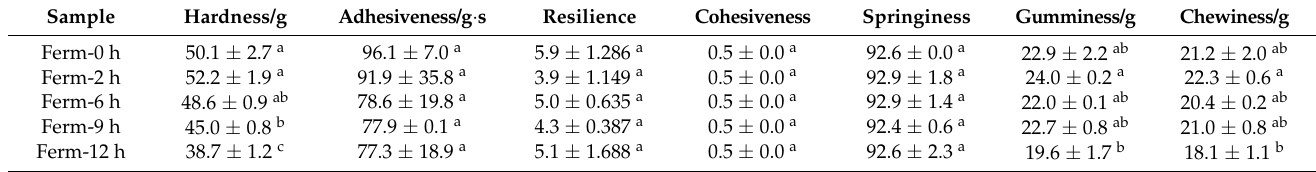
Table 3. Gel textural properties of wheat starch separated from bifidobacteria-fermented dough at different fermentation